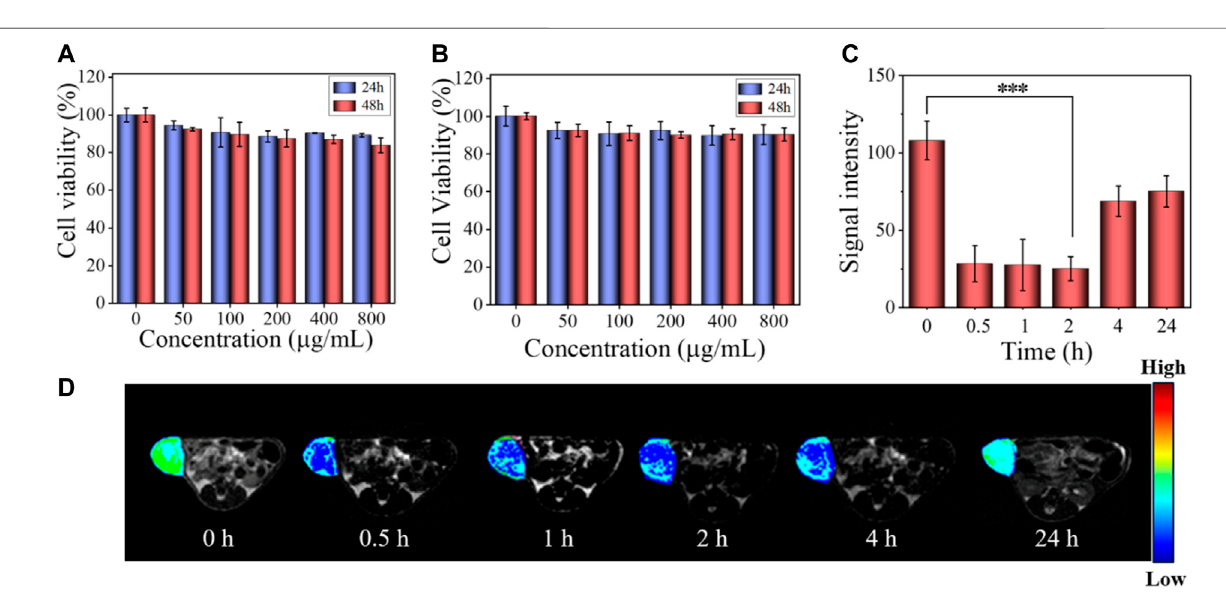
here, the boiling point of PFH was increased by the Laplace pressure difference between the inside and outside of the silica lipid shell to a certain extent (Yang et al., 2018). The